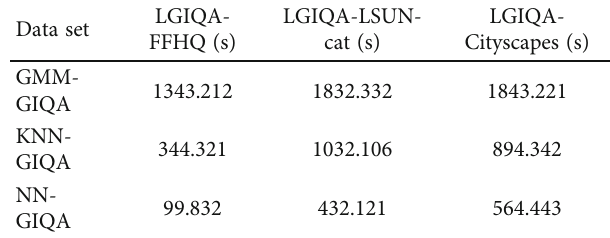
Table 2: Running time cost of di ff erent IQA